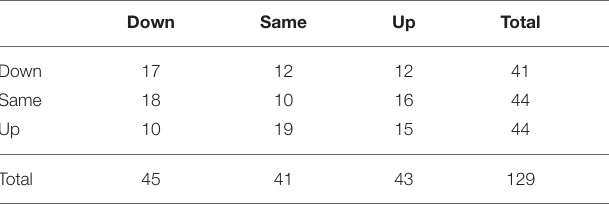
Rows: indicated (correct) direction; column: performed